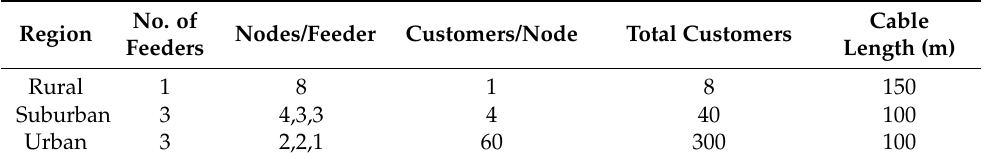
Table 1. Network layout for three distinct Finnish regions.